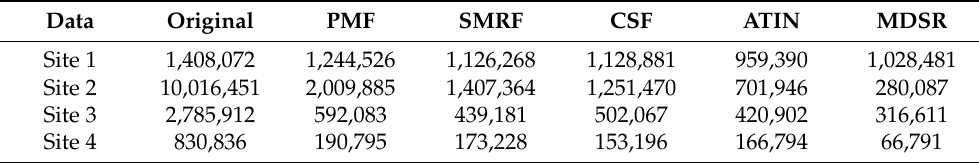
Table 3. Number of points in original and filtered clouds.